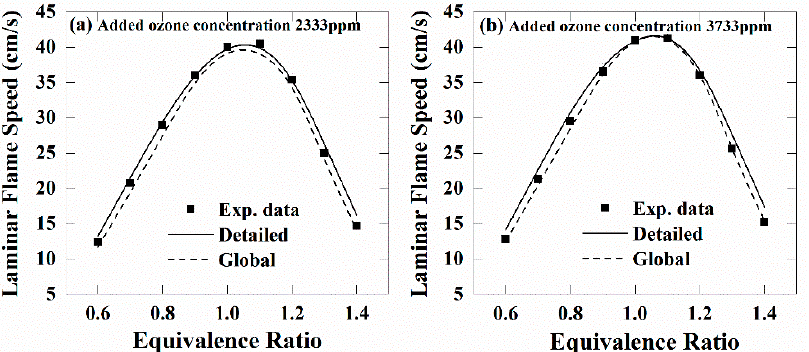
Figure 6. Comparison of laminar flame speeds between simulation results and experimental data from Wang [31] at different added ozone concentrations: the scatter plot represents the experimental data, the solid line represents the simulation results by the detailed mechanism, and the dashed line represents the results by the global mechanism at added ozone concentrations of ( a ) 2333 ppm and ( b ) 3733 ppm.